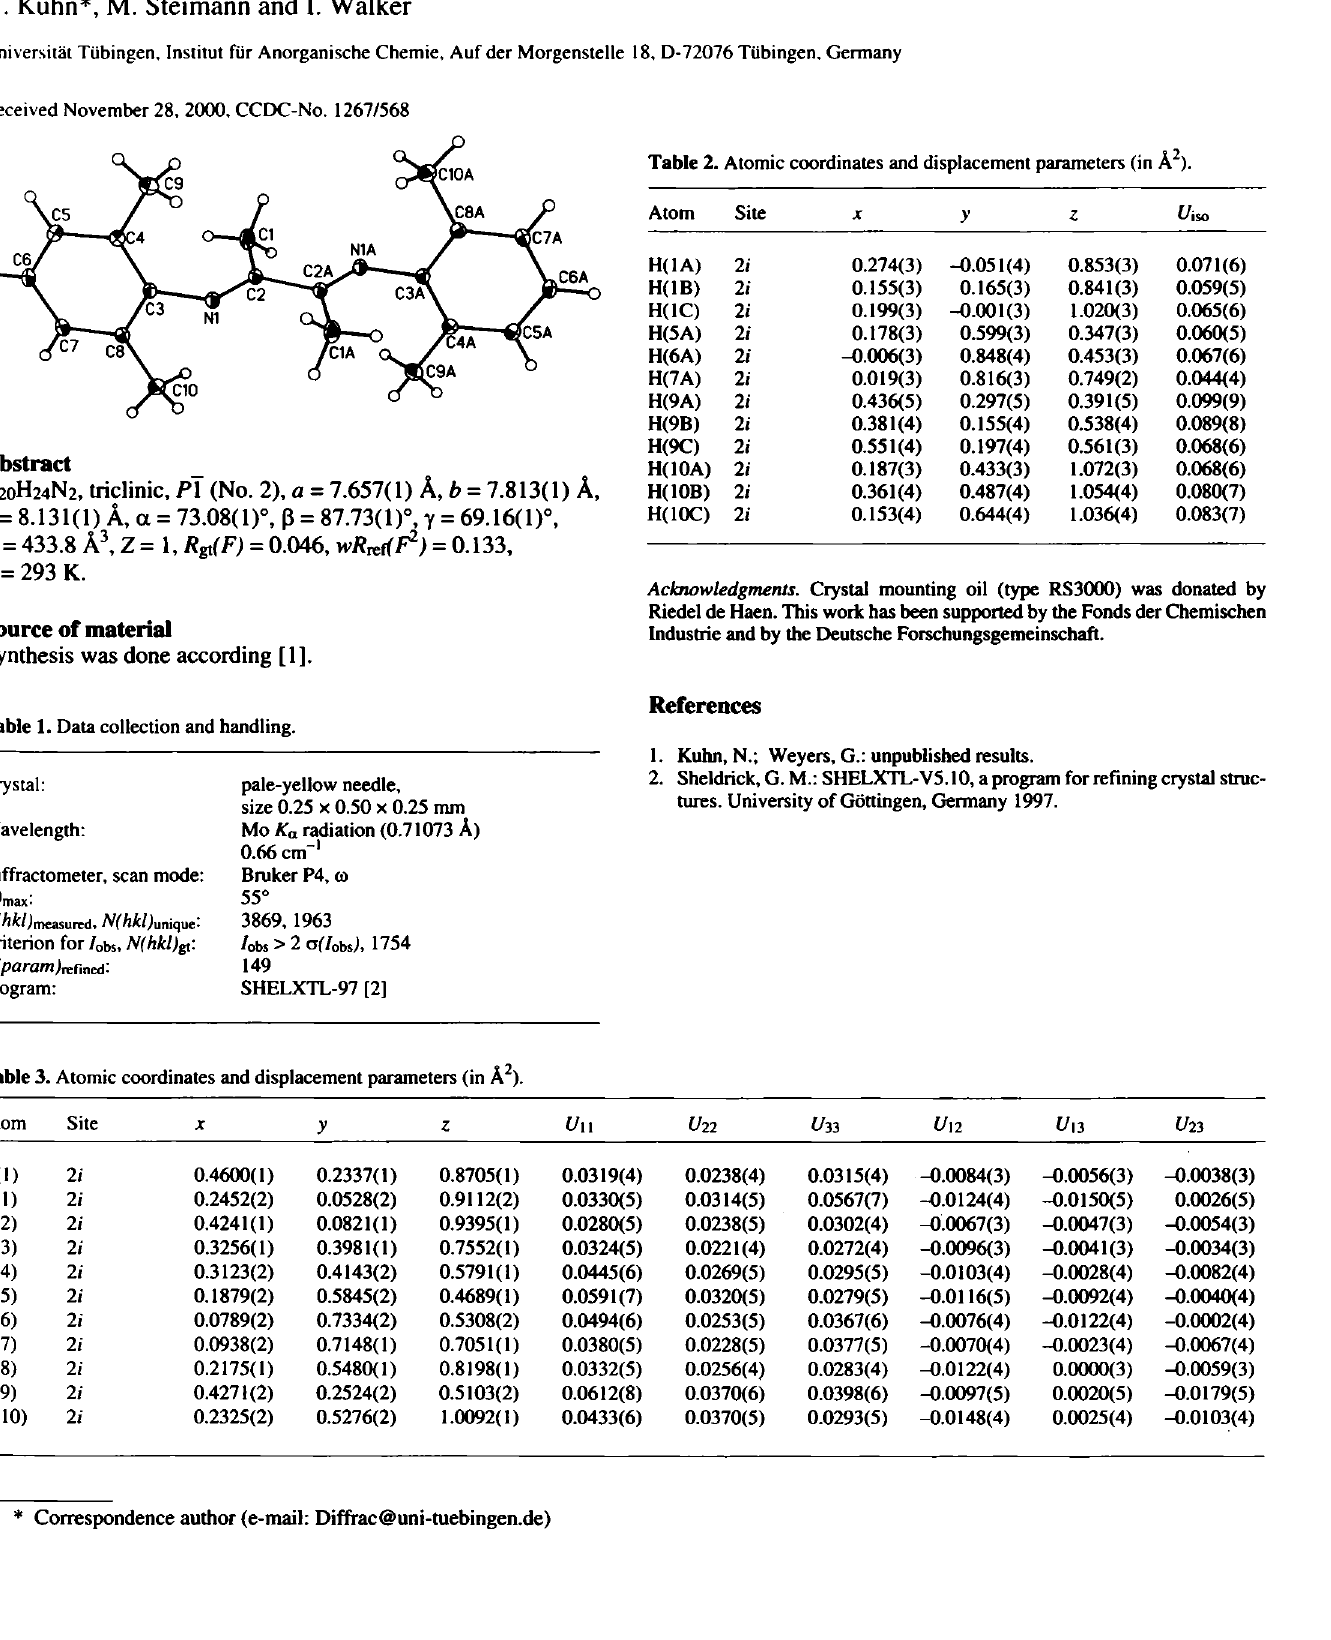
Table 2. Atomic coordinates and displacement parameters (in Ä 2 ).